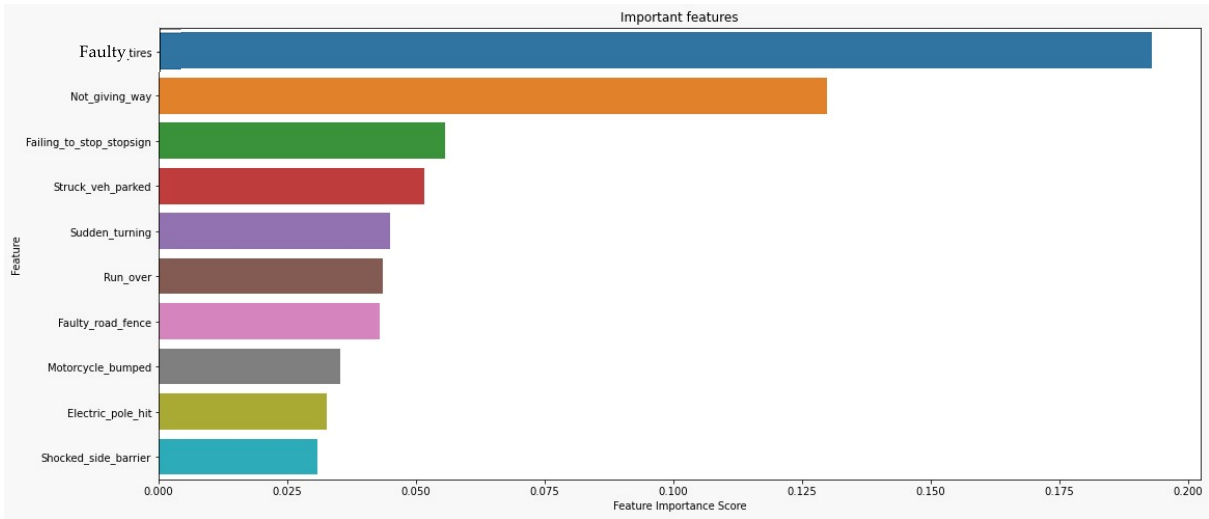
Figure 6. Variable importance using random forest classifier.